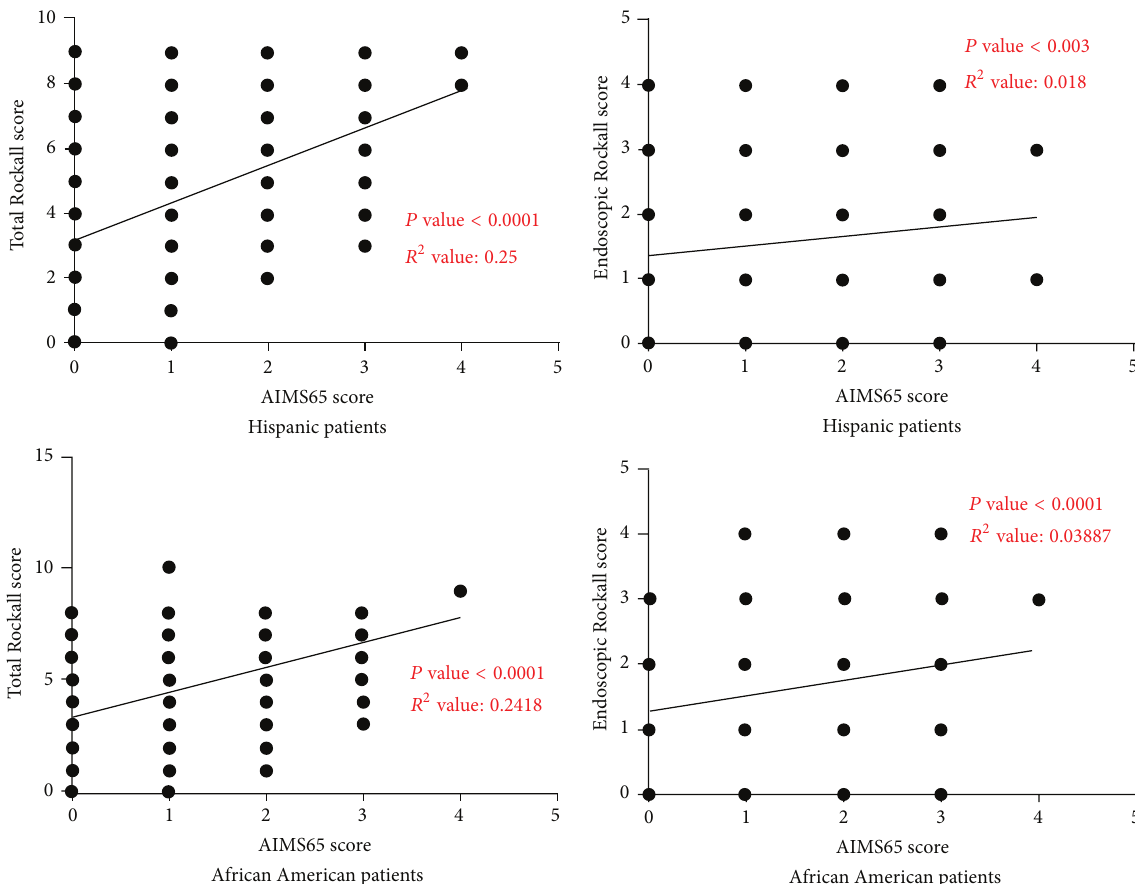
Figure1:StatisticallysignificantcorrelationwasfoundbetweenTotalRockall/EndoscopicRockallscoresandAIMS65scoresinbothHispanic and African American